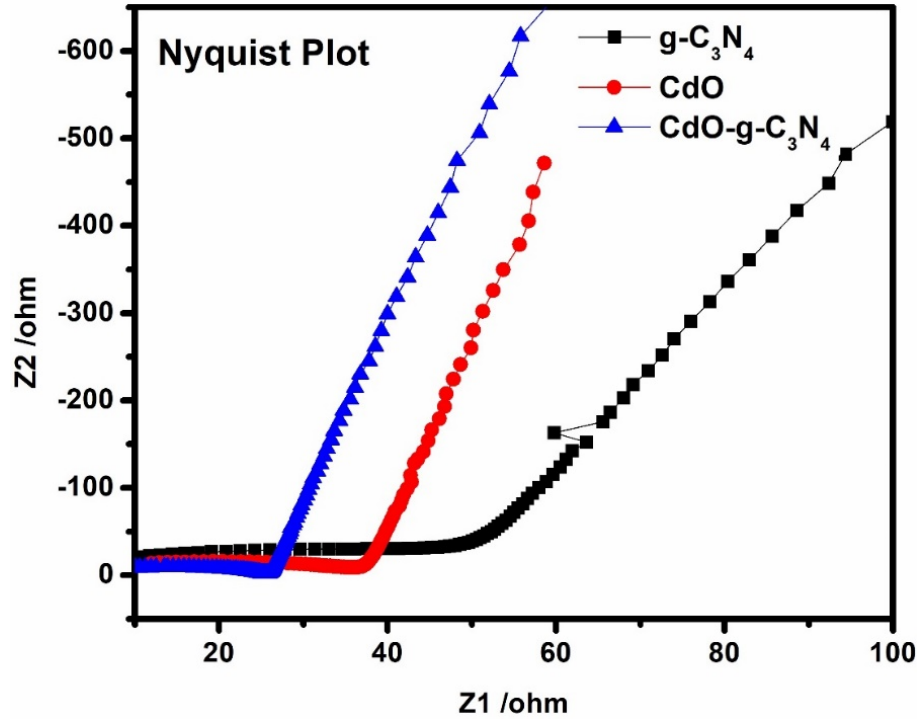
Figure 8. EIS analysis and Nyquist plot of g-C 3 N 4 , CdO and CdO-g-C 3 N 4